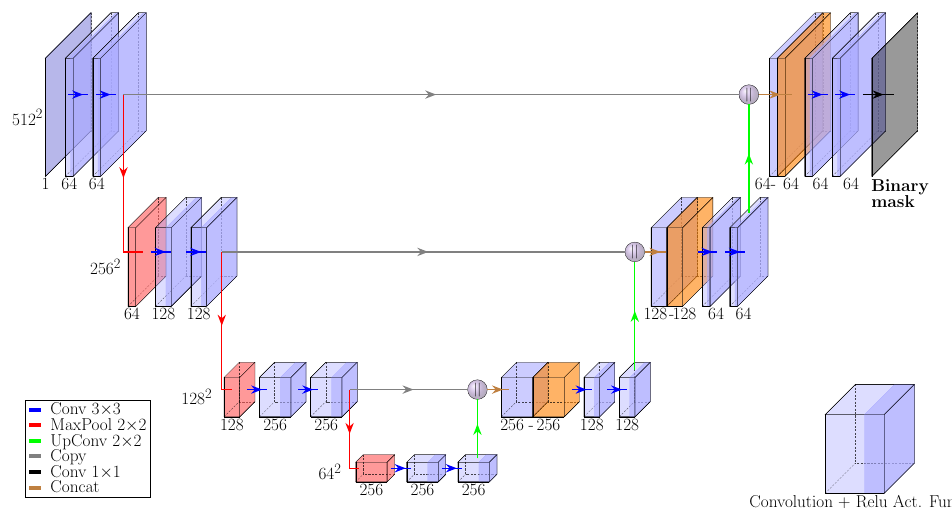
Figure 1. U-Net model with features dimensions and number of features